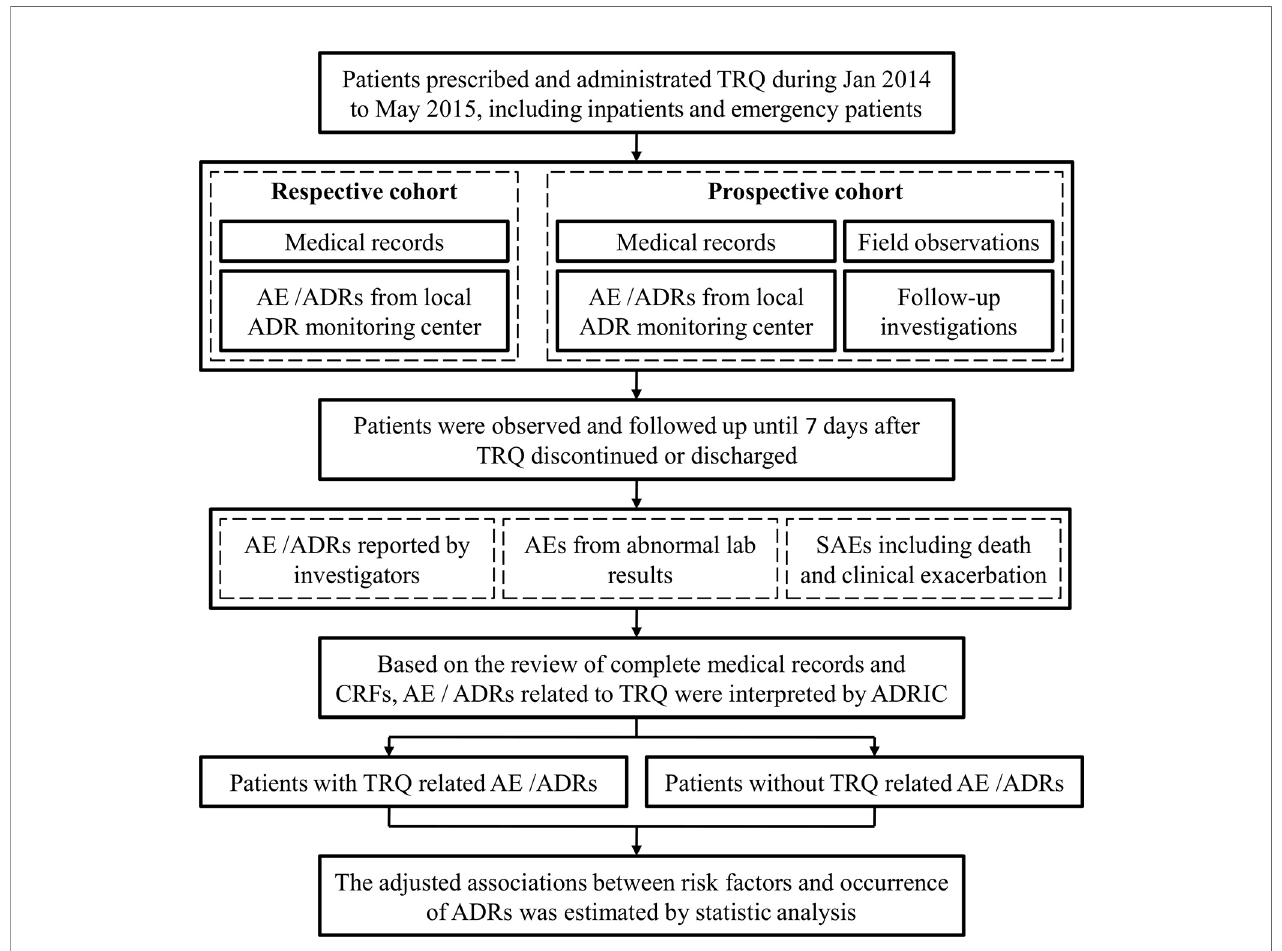
FIGURE 1 | Flow chart for adverse event (AE)/adverse drug reactions (ADRs) identi fi cation. The fi gure depicts the fl ow of AE/ADR identi fi cation from data collected from fi eld observations and follow-up investigations in respective and prospective cohort. TRQ, Tanreqing injection; SAEs, serious adverse events; ADRIC, ADR interpretation